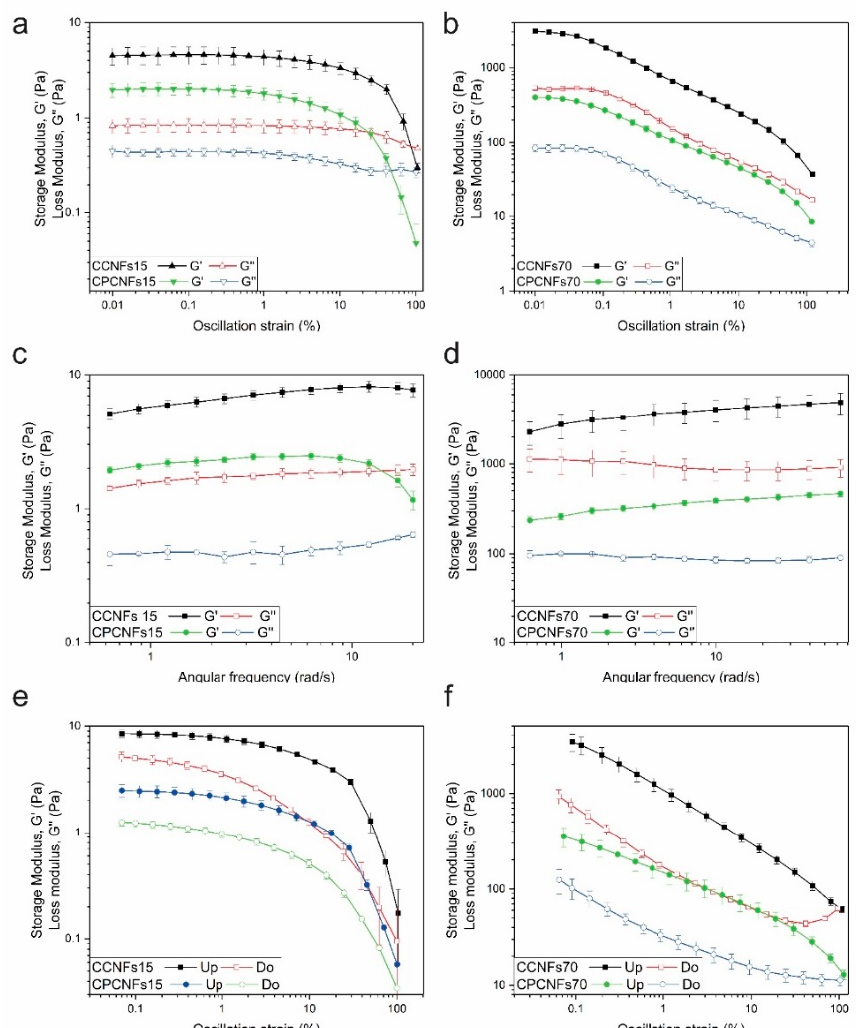
Figure 7. Rheological characterization of coconut oil emulsions with and without polysorbate 80 in the presence of 0.15 wt.% of CNFs, by amplitude ( a ) and frequency ( c ) sweeps and amplitude hysteresis ( e ) and in presence of 0.7 wt.% of CNFs, by amplitude ( b ) and frequency ( d ) sweeps and amplitude hysteresis ( f ). Hysteresis measurements taken with an upward amplitude are named as “Up” and with a downward amplitude are named as “Do”.